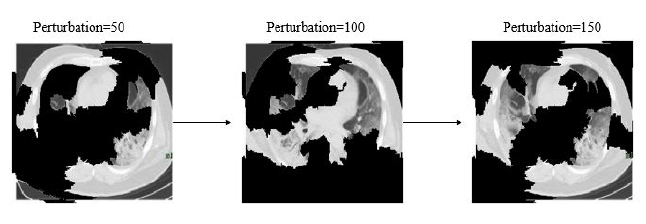
Figure 9. Examples of perturbation vectors and perturbed images.